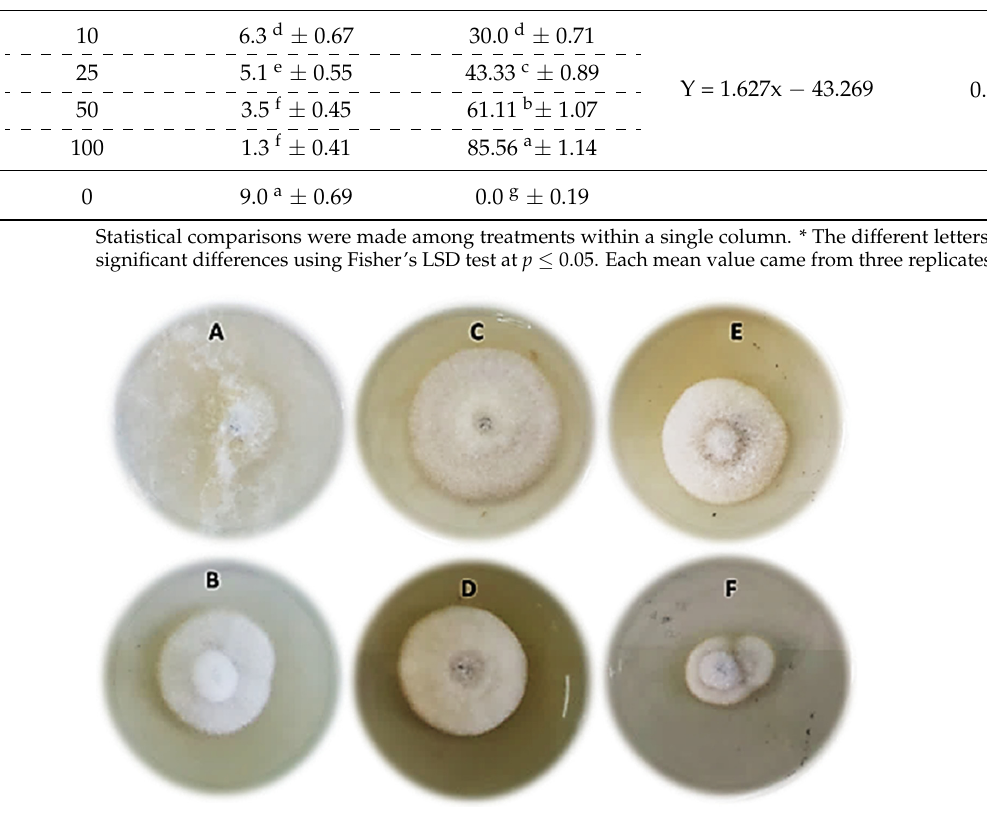
Figure 3. Effect of Cu 2 ONPs and chemical fungicide on the radial growth of Fusarium solani A = control, B = fungicide, C = Cu 2 ONPs (0.35M) at a concentration of 50 µg/L, D = Cu 2 ONPs (0.35M) at ( A ) = control, ( B ) = fungicide, ( C ) = Cu 2 ONPs (0.35 M) at a concentration of 50 µ g/L, ( D ) = Cu 2 ONPs a concentration of 100 µg/L, E = Cu 2 ONPs (0.30M) at a concentration of 50 µg/L and F = Cu 2 ONPs (0.35 M) at a concentration of 100 µ g/L, ( E ) = Cu 2 ONPs (0.30 M) at a concentration of 50 µ g/L and (0.30M) at a concentration of 100 µg/L. ( F ) = Cu 2 ONPs (0.30 M) at a concentration of 100 µ